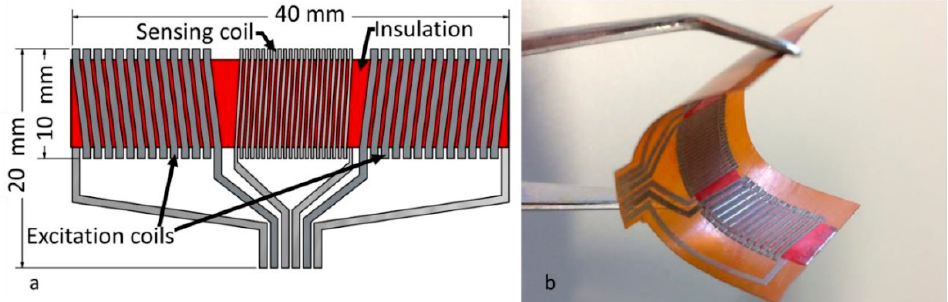
Figure 15. Structure of the printed fluxgate magnetometer on wearable intelligent device ( a ) and the experimental picture ( b ).